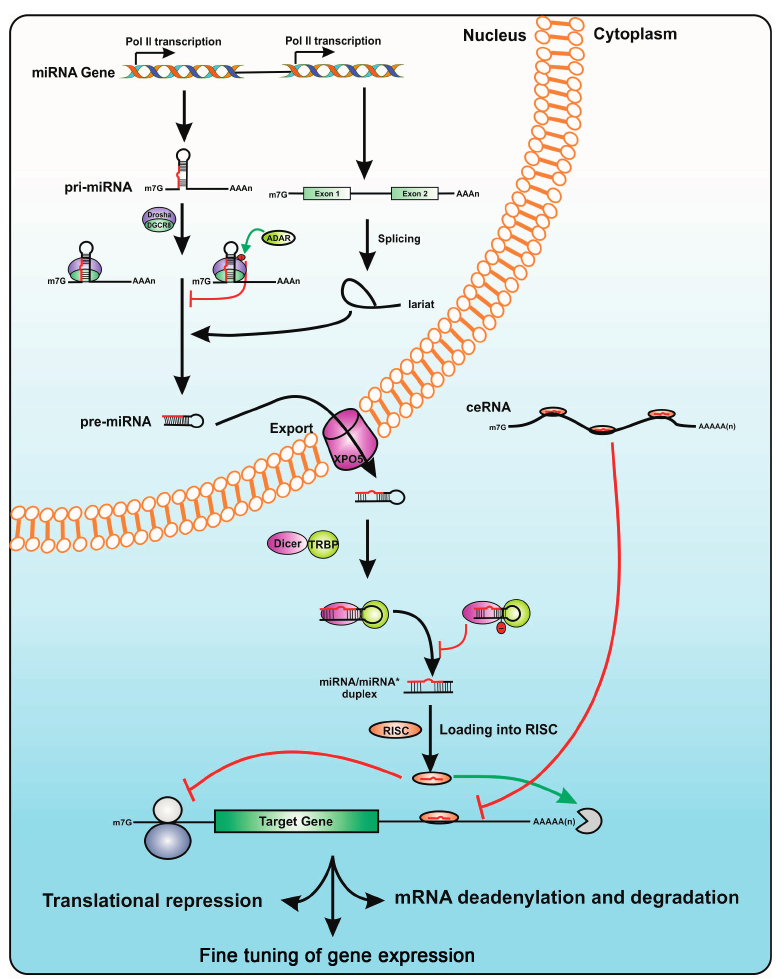
Figure 2. Overview of the miRNA biogenesis pathway. miRNA genes are transcribed in the nucleus by RNA Pol II as long pri-miRNA transcripts that are 5 ′ capped and 3 ′ polyadenylated. The pri-miRNA sequence folds into a hairpin loops structure that is recognized and processed by the Microprocessor complex Drosha-DGCR8, generating a pre-microRNA. Mirtrons , a class of unconventional miRNAs, are encoded in small introns and do not require Drosha processing. The intron lariat excised by the spliceosome is refolded into a pre-miRNA hairpin loop. The pre-miRNA is exported from the nucleus to the cytoplasm by exportin 5 (XPO5), where is further cropped by Dicer in complex with TRBP, yielding a ~22 nt double-stranded RNA called miRNA/miRNA* duplex. The functional mature miRNA is loaded together with Argonaute proteins into the RISC complex, guiding RISC to silence a target mRNA through translational repression or deadenylation. The biogenesis pathway of miRNAs are post-transcriptionally controlled by RNA editing. A-to-I editing of the miRNA’s precursors, a reaction catalyzed by ADAR enzymes, can block Drosha and Dicer processing, and thereby regulates the availability of mature miRNA in the cell. Competing endogenous RNAs (ceRNAs) can regulate mRNA expression levels by competing for shared miRNA binding